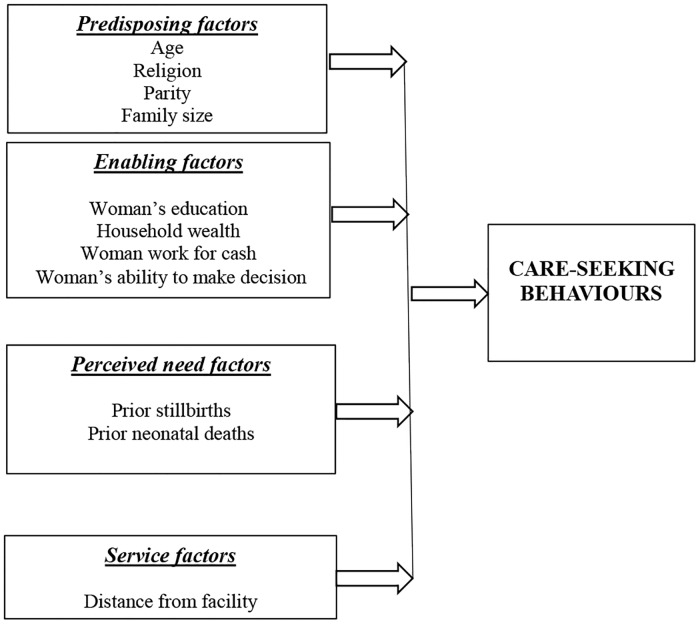
Conceptual framework.Note: Adapted from Andersen RM. Revisiting the behavioral Model and access to Medical Care: Does It Matter? Journal of Health and Social Behaviour 1995, vol. 36 (March): 1–10.